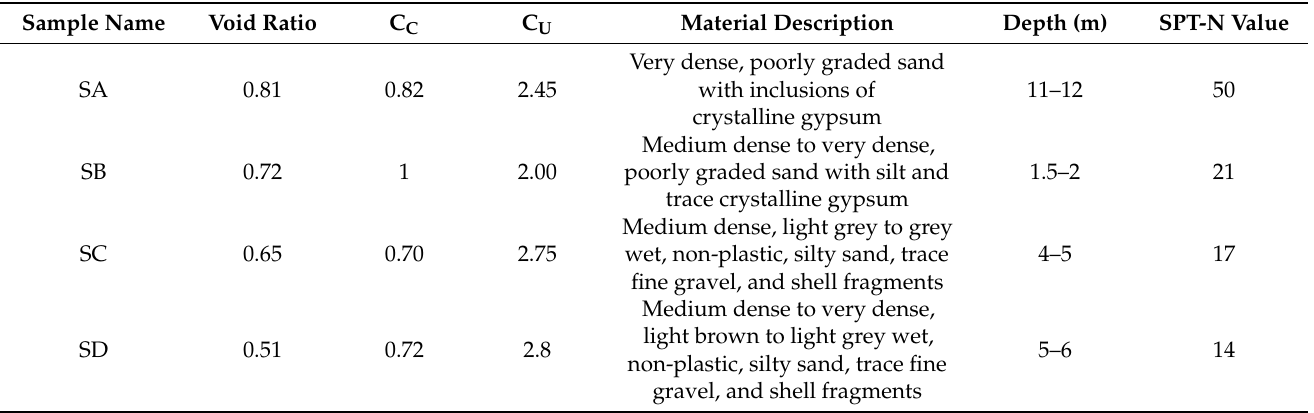
Table 1. Material properties of